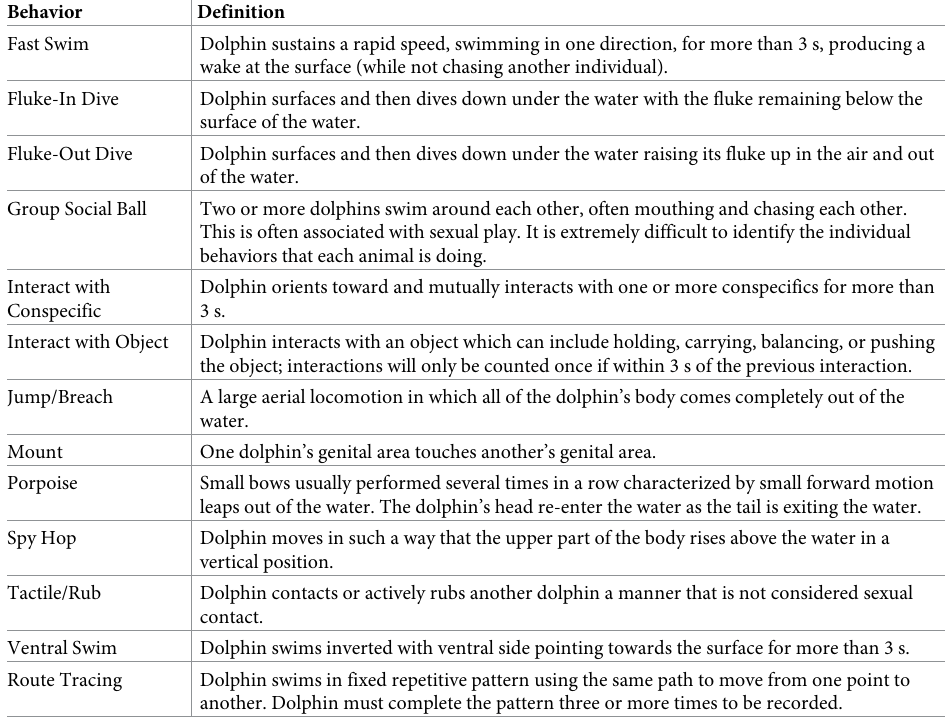
Table 2. Ethogram utilized to score videos by trained reliable